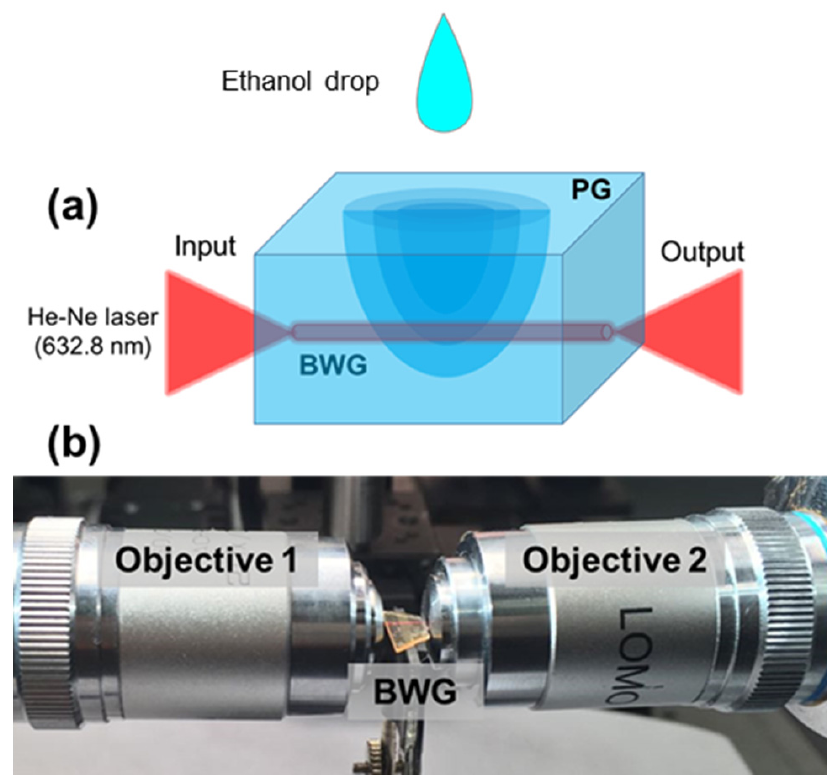
Figure 6. ( a ) Schematic view of liquid-immersing procedure for PG with the inscribed cylindrical- shaped waveguide. ( b ) Photo of the experimental setup for waveguide sensor ability testing.